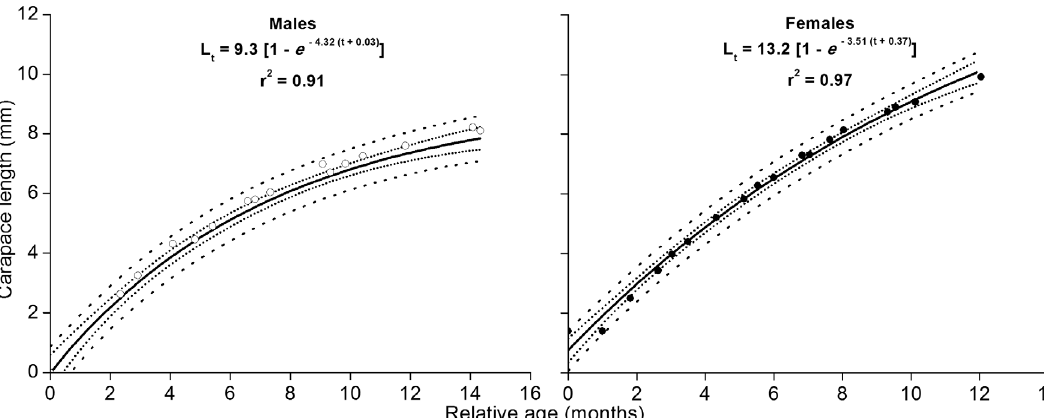
Figure 8. Von Bertalanffy growth curves for male and female data of Palaemon pandaliformis based on monthly length-frequency distribution from September 2009 and August 2010 in Rio Salsa, Canavieiras, Bahia, Brazil. Center line: mean; dotted lines: confidence intervals (95%); dashed lines: prediction interval (95%). Individual points represent modal carapace length (CL) derived from size-frequency distributions.